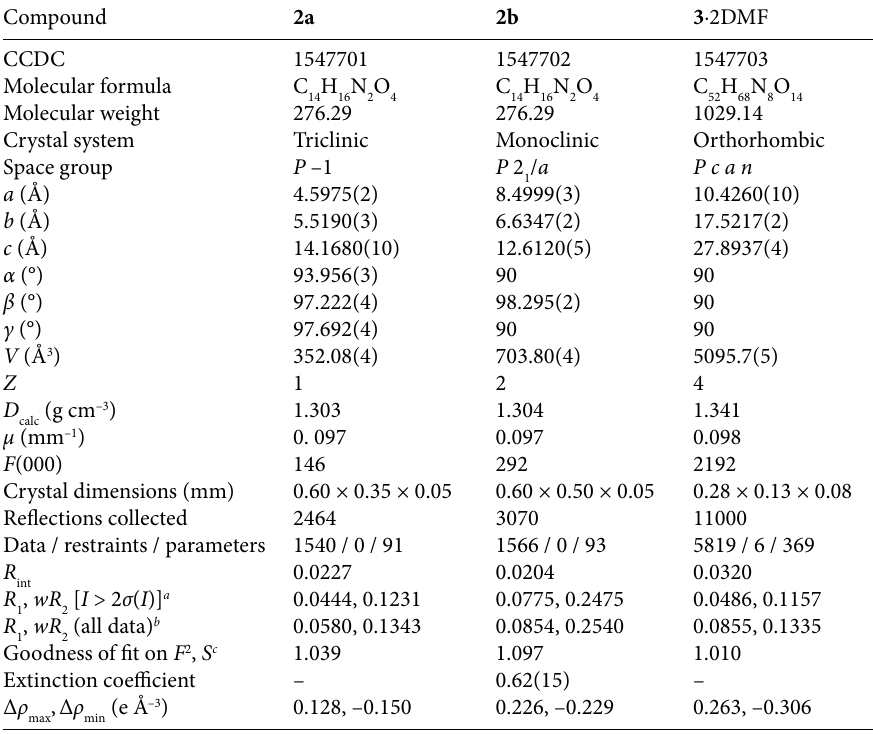
Table 1. Crystal data and refinement parameters for the compounds 2a , 2b and 3